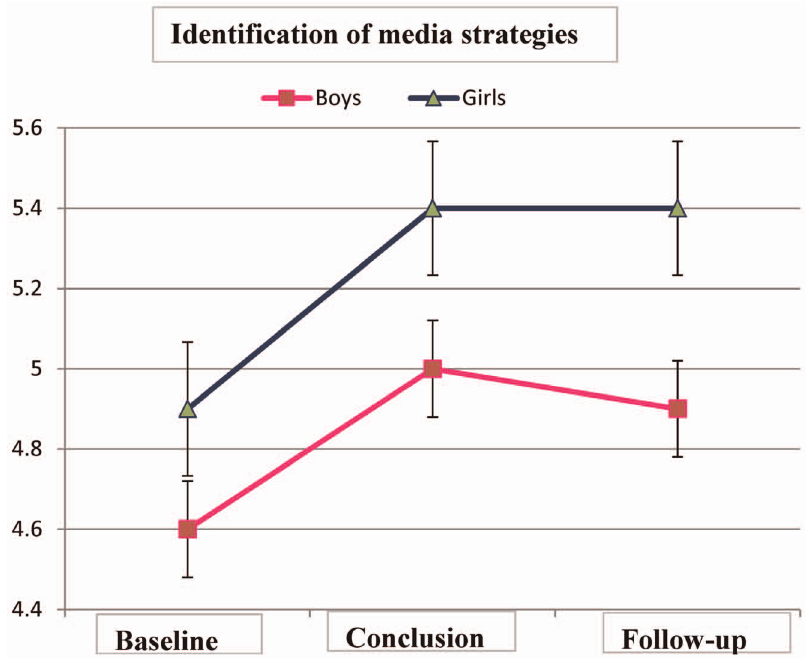
Figure 2. Identification of media strategies by girls and boys (Means ± SD).